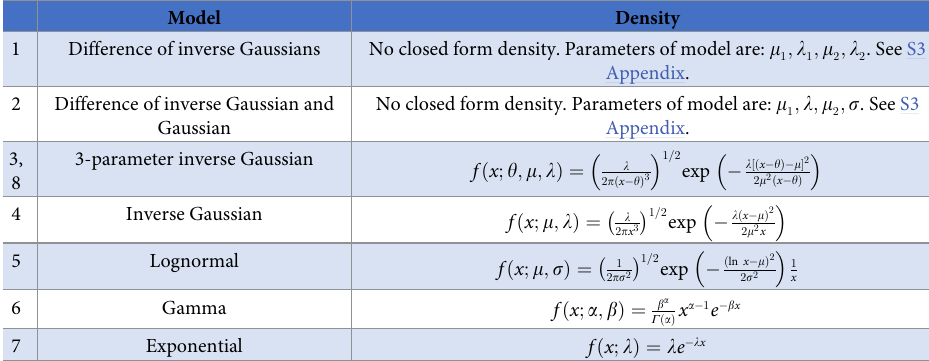
Table 1. Model descriptions for Models